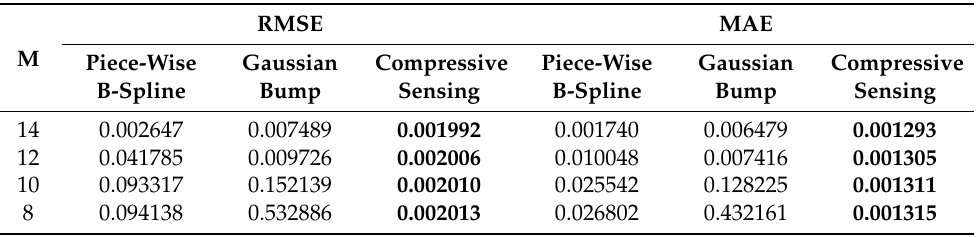
Table 1. The recovery error of the Plank spectrum with three spectrum-unfolding